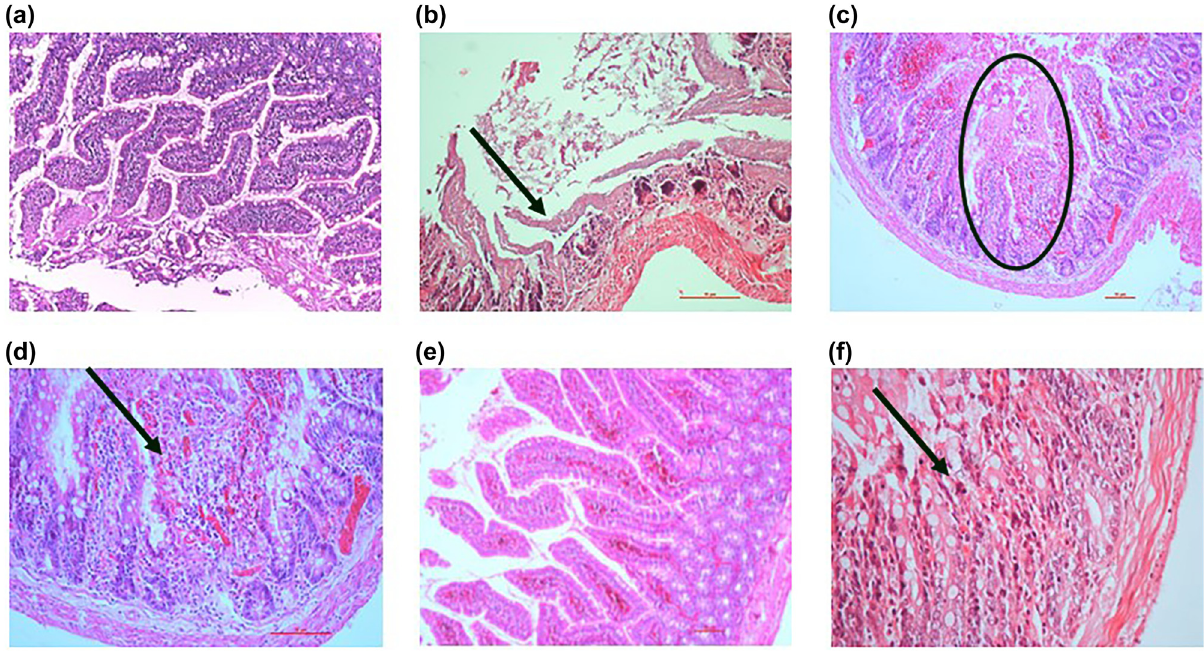
Figure 3: The histological morphology of intestinal with HE staining. (a)Shamgroup,score0,ileummucosaofnormalvillistructure(HEx100);(b)Controlgroup,score4,prominentnecrocytosis,hemorrhage,and cell fracture are seen (indicated by arrow) (HE × 100); (c) Treatmented clinoptilolite group, score 2, the ischemic findings regressed to varying degreesineacharea.Thechangesaretrackedinnear-normalmucosaontheright,mucosalischemiawithmorenecrocytosisinthemiddle(in the circle), mild hemorrhagic on the left (HE × 100). (d) Treatmented clinoptilolite group, score1, mostly normal mucosa is observed that is occasionallyverylittlecellularedema,cellfracture,andhemorrhage(indicatedbyarrow)(HE × 200)(e)Treatmentedclinoptilolitegroup,score 0, it was observed in rare areas on hemorrhage and cellular edema, mucosa with normal histology in most areas (HE × 100) (f) Treatmented clinoptilolite group, apoptotic cells (indicated by arrow) (HE ×